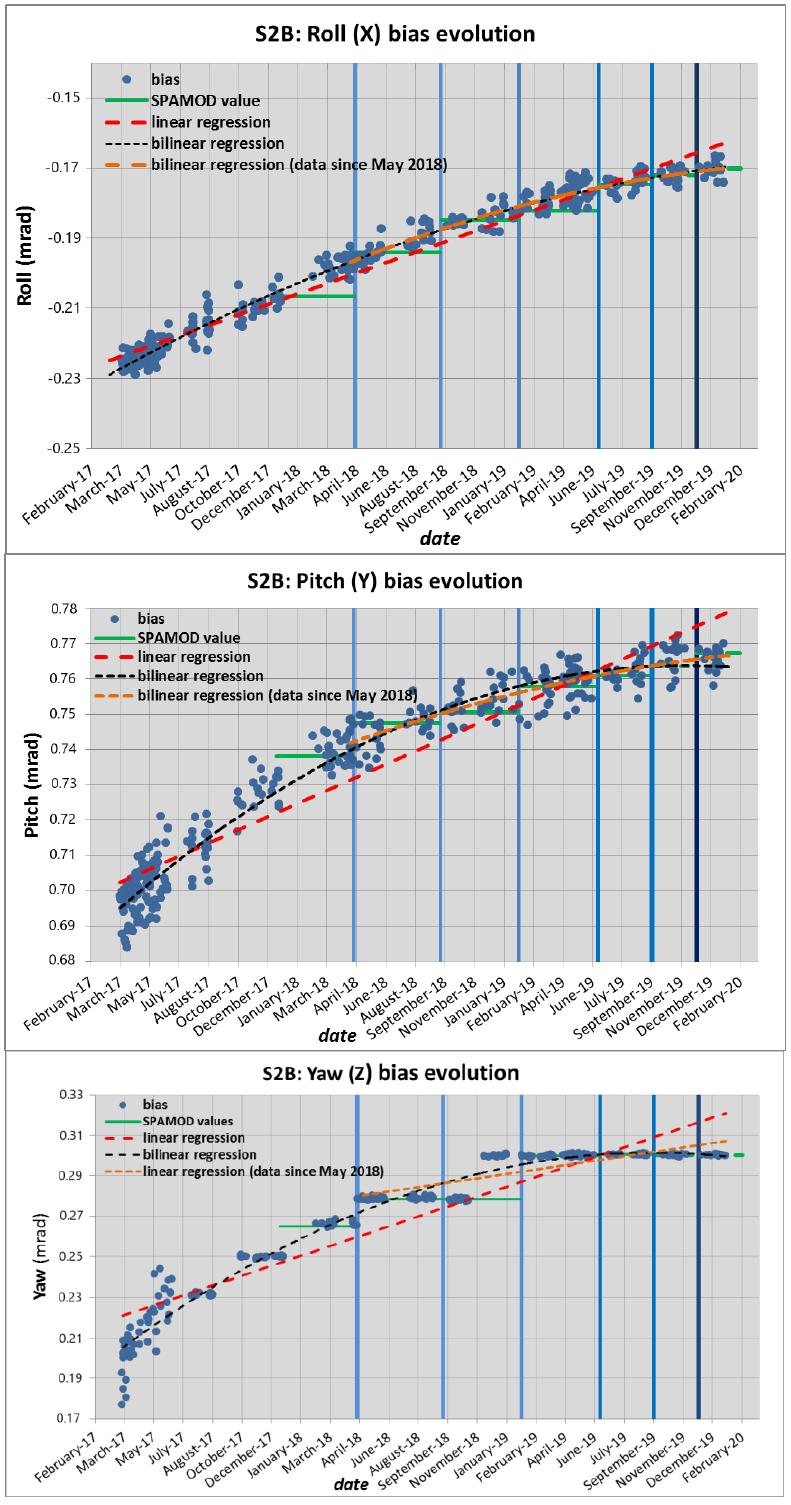
Figure 7. Roll, pitch and yaw angle measurement biases for Sentinel 2B for the first 550 days following launch. Note that pitch and yaw angle bias is stabilizing, while roll continues to drift.